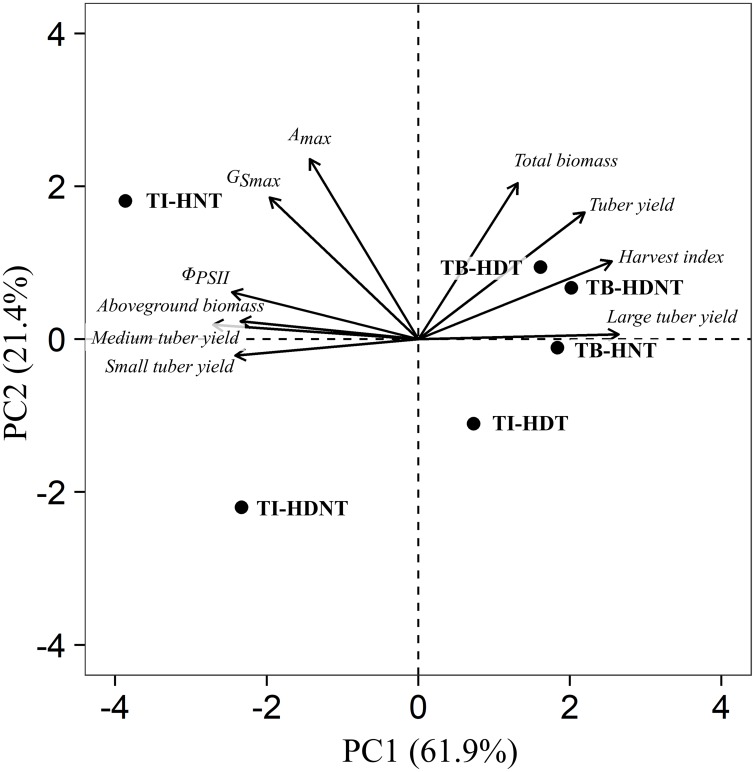
PCA bi-plot of the agronomic- and photosynthetic-traits for the potatoes grown under different thermal regimes at TI and TB. In order to remove the effect of different radiation conditions between TI and TB, the measurements of agronomic- and photosynthetic-traits were transformed to the percentage changes compared to the controls of each growth stage.